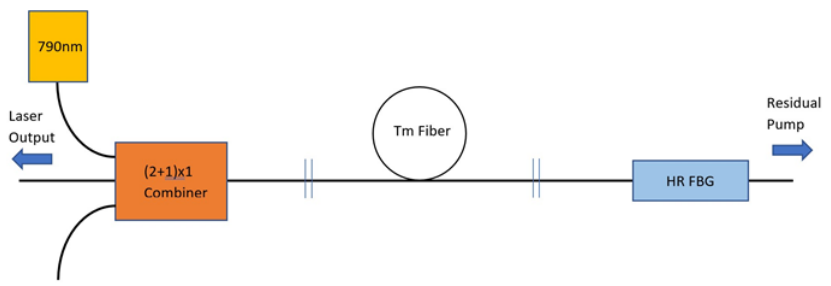
Figure 2. Thulium Fiber Laser Schematic.